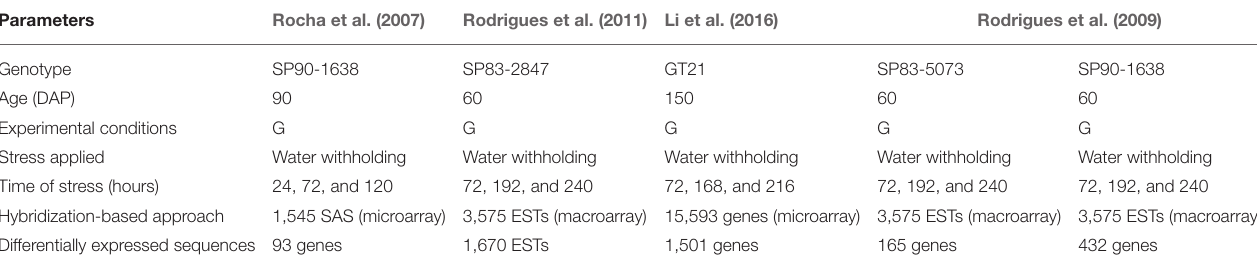
TABLE 3 | Experimental conditions of large-scale gene expression assays in sugarcane under drought.